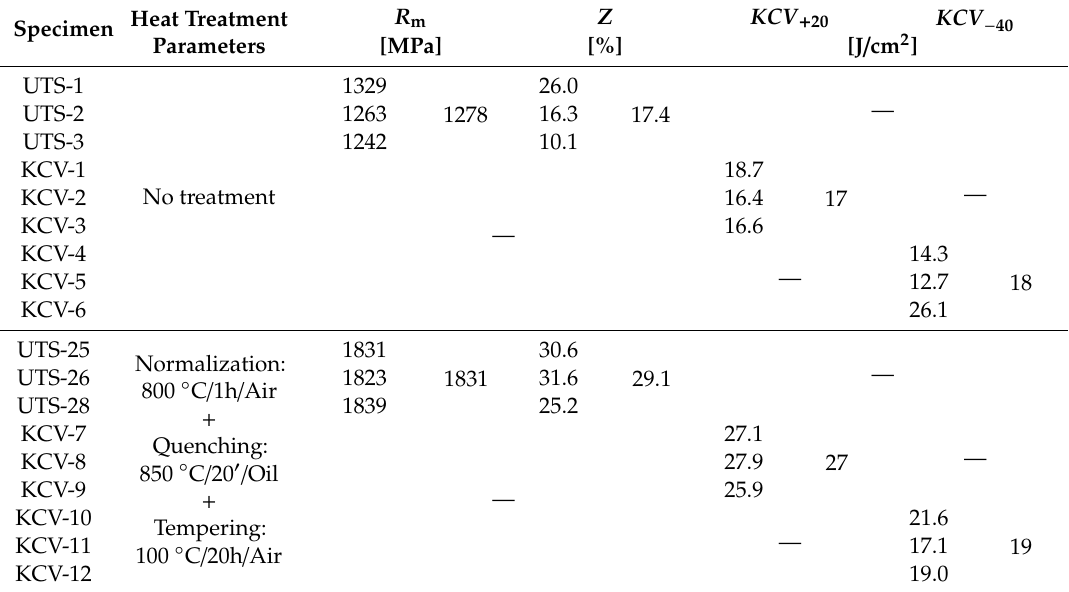
Table 5. Heat treatment parameters and selected mechanical properties of Hardox Extreme welded joint: Heat Treatment Specimen